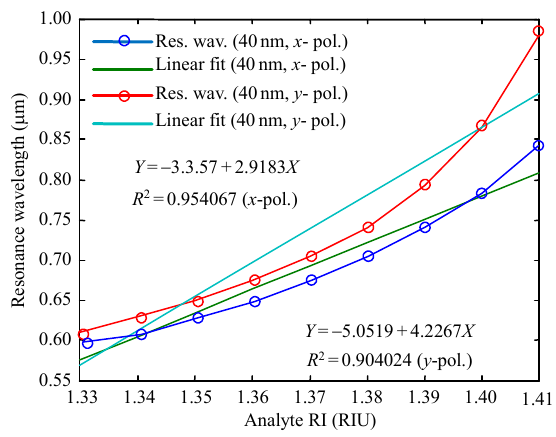
Fig. 12 Linear fitting of the resonance wavelength as a function of analyte